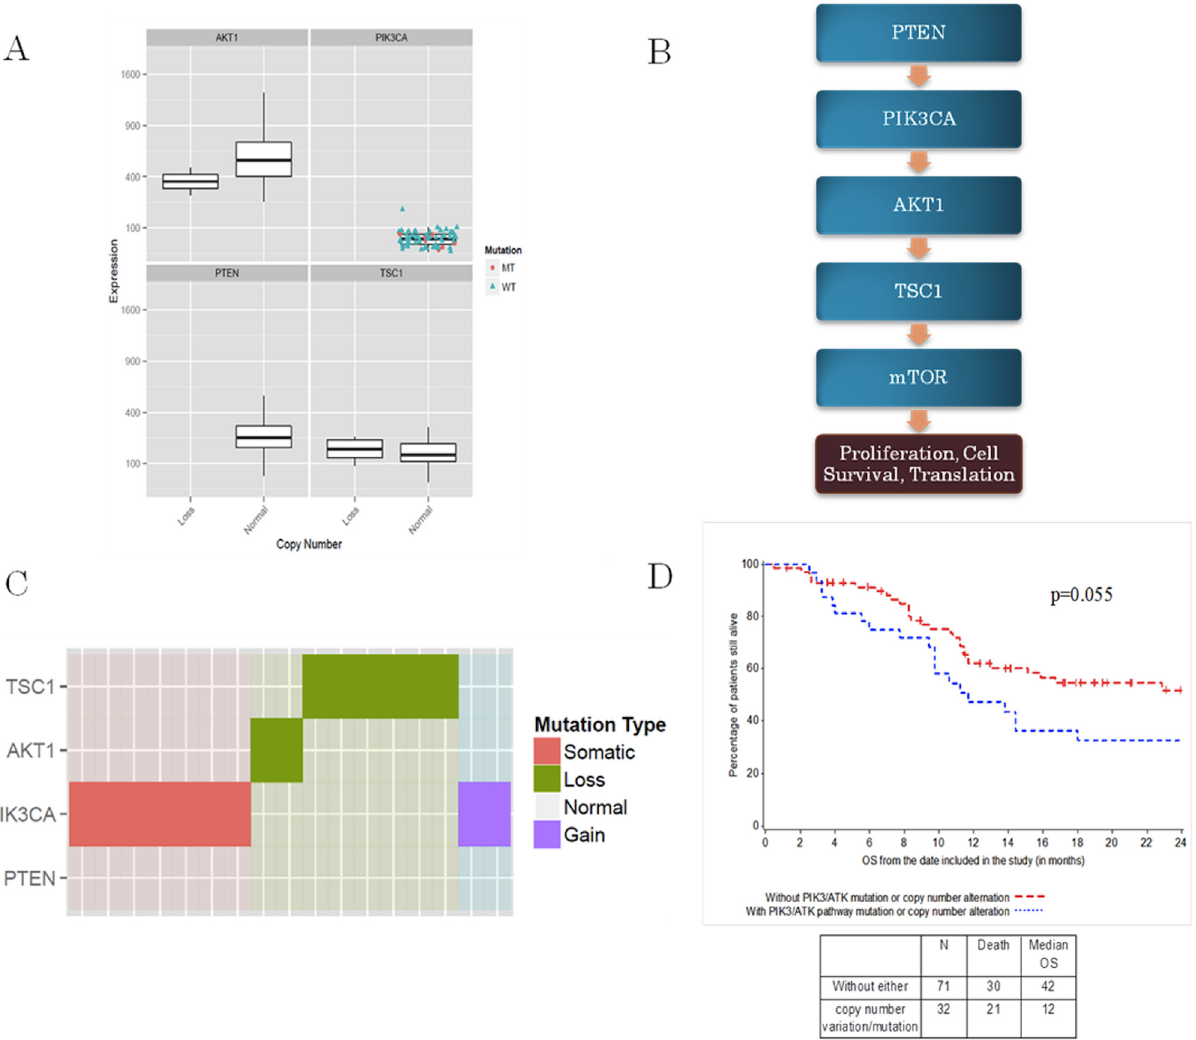
Fig 1. Association between mutations or CNV and OS. A: PIK3CA/AKT/mTOR pathway; B: Gene expression level analysis whithin the PI3KCA/AKT pathway; C: Heat map: mutations across the PIK3CA/AKT/mTOR pathway; D: Association between PIK3CA/AKT/mTOR pathway mutations or CNV and